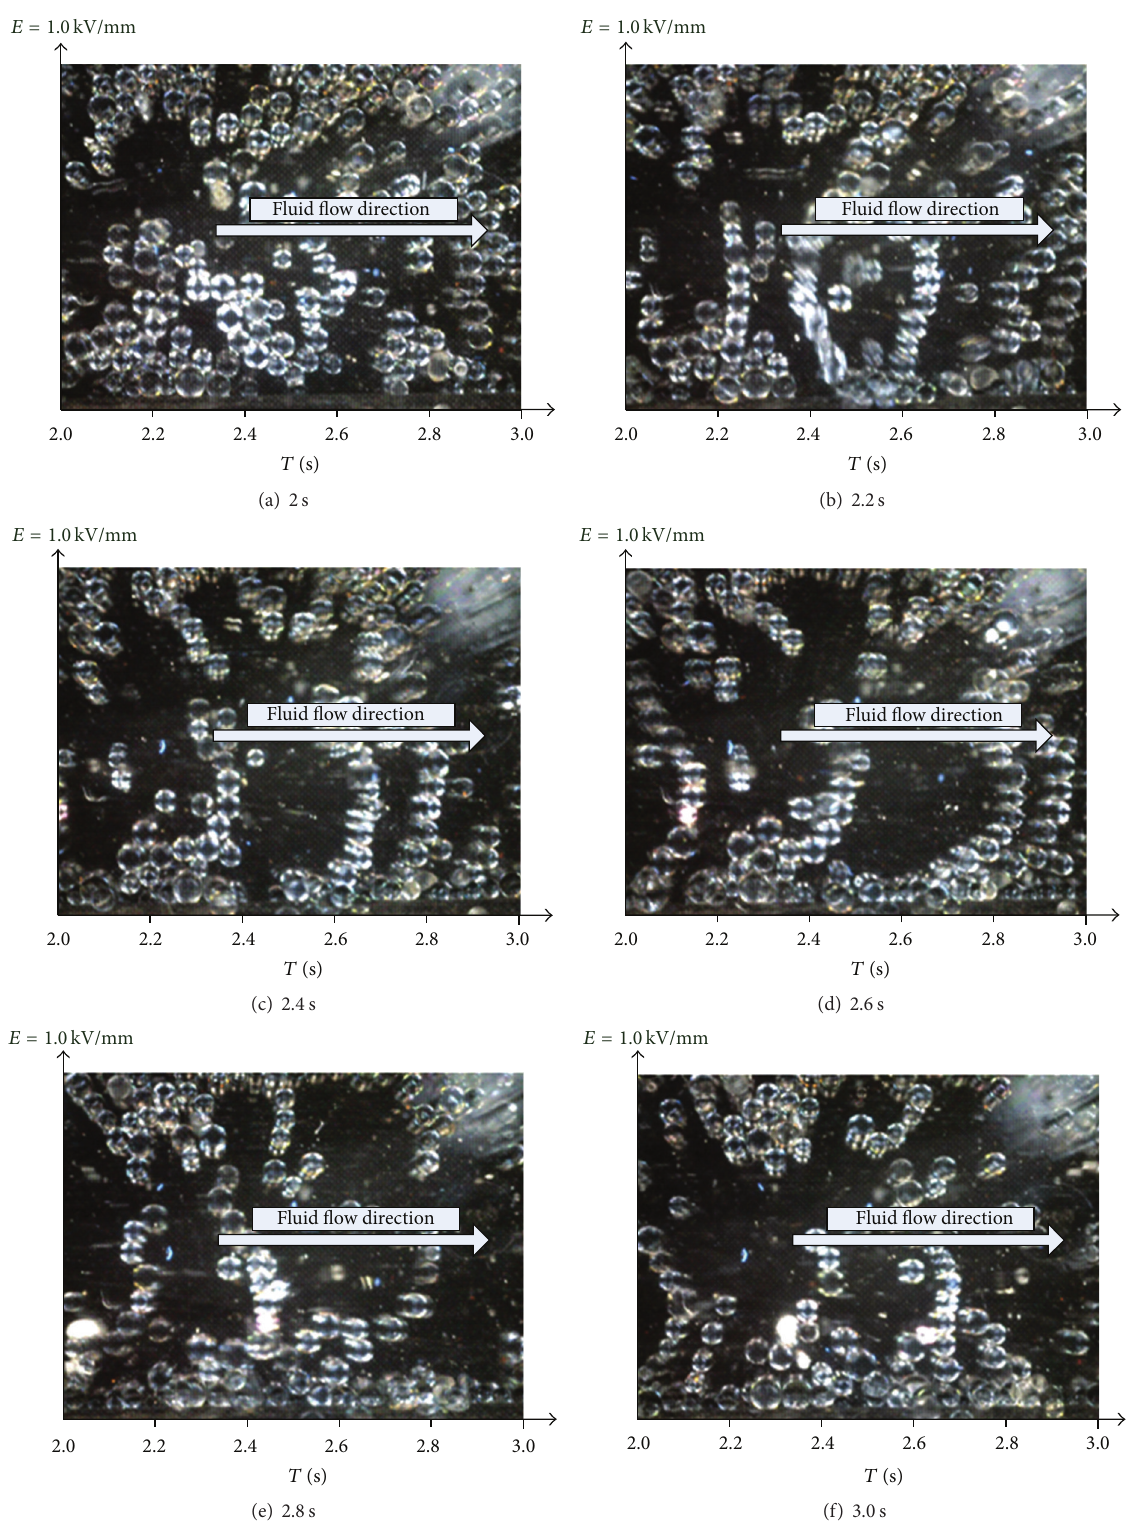
Figure 4: Structure evolution processes of the ER particles ( 𝐸 = 1.0 kV/mm, V = 2